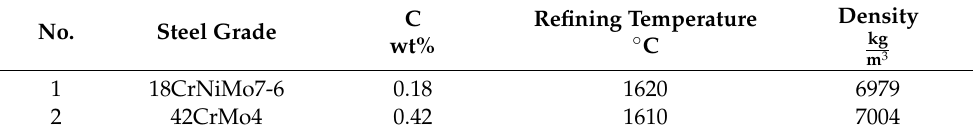
Table 2. Calculated melting point and density of steel at various C contents.